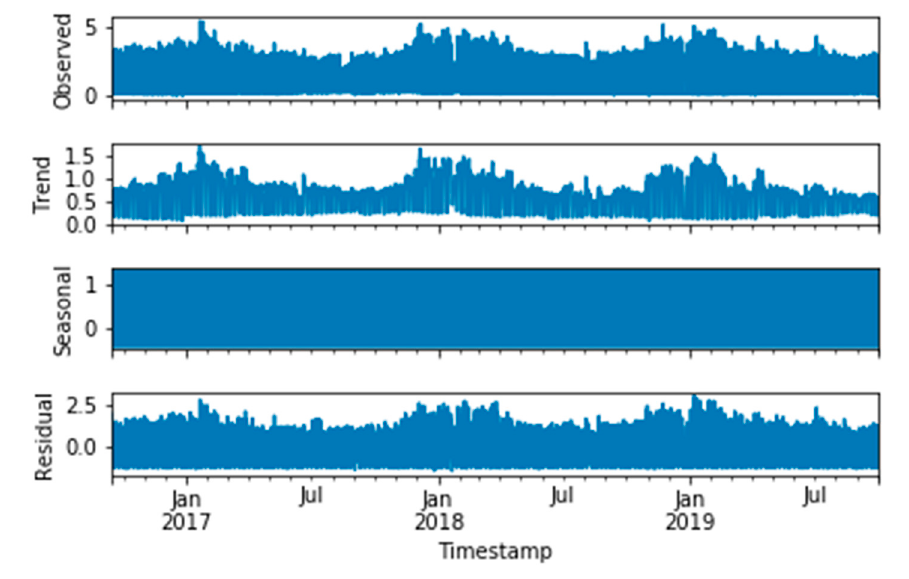
Figure 4. Hourly kWh consumption from September 2016 to September 2019 with the summer and winter periods highlighted.